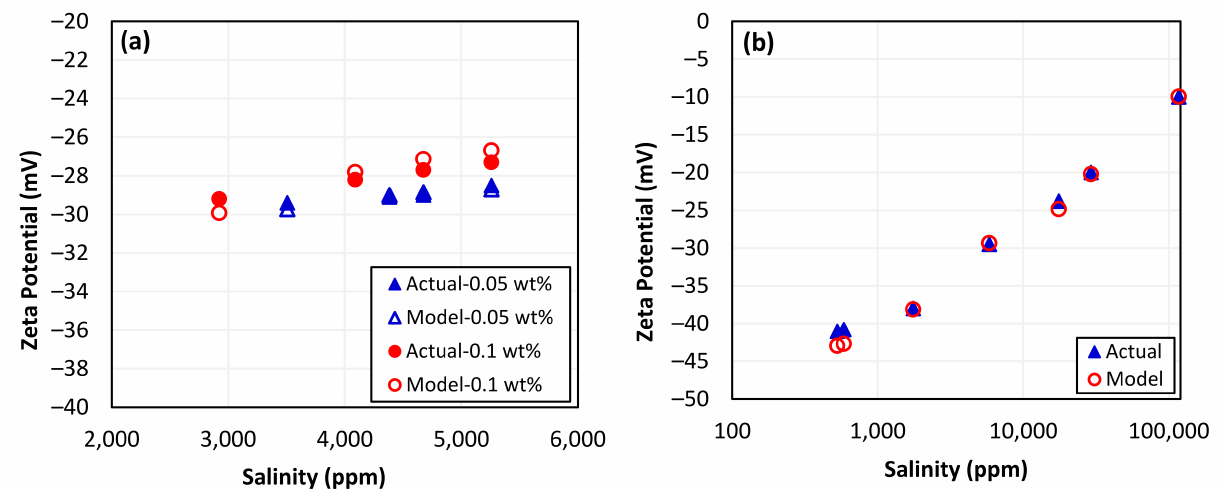
Figure 6. Zeta potential predictions using ANN model: ( a ) with nanoparticles and ( b ) with